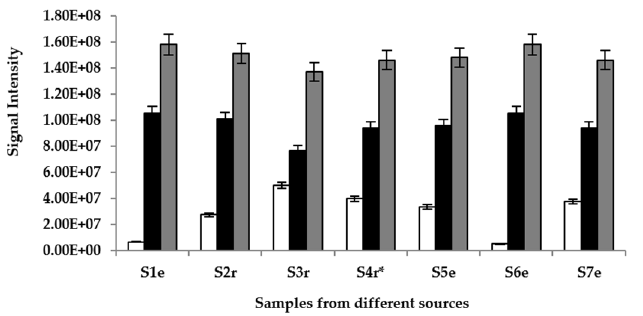
Figure 2. Signal intensities recorded for three main palm wine aroma volatiles after APCI-MS analysis: ( □ ) ethanol, ( ■ ) acetic acid and ( ) ethyl acetate in samples (S) 1–7, sourced from different locations (r = Raphia sp.; e = Elaeis sp.; * = sample supplemented with S. gabonensis ).